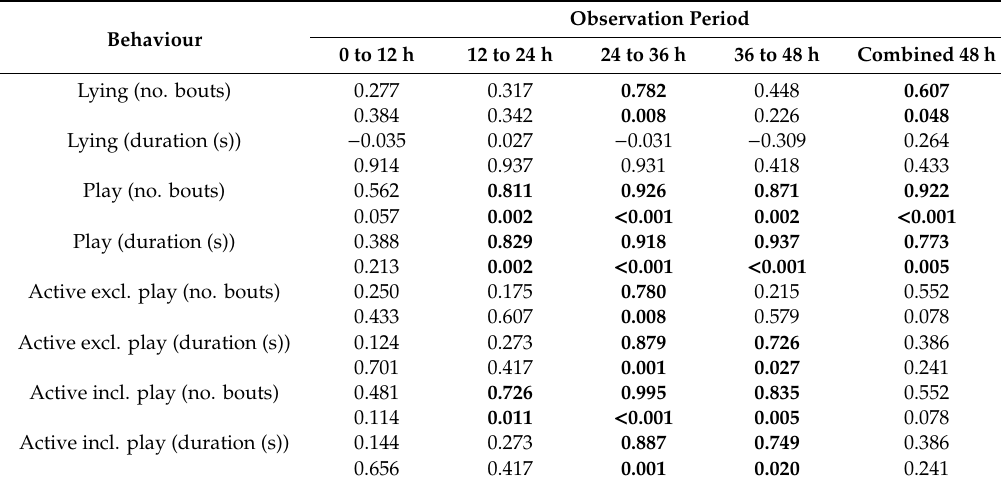
Table 3. Correlation coe ffi cient and p-values for Pearson and Spearman rank correlation of motion index and observed behaviour (duration(s) and number of bouts) for each 24 h observation period and the combined 48 h observation period. Bold font indicates significant results.